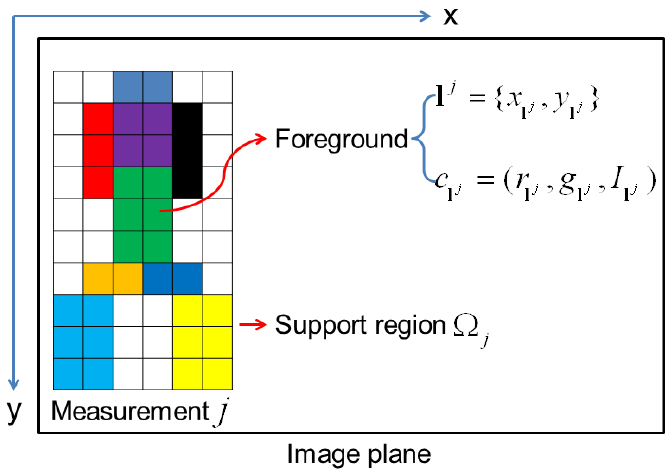
Figure 5. A schematic diagram of the colour distributions of the foreground pixels and the support region of the measurement j